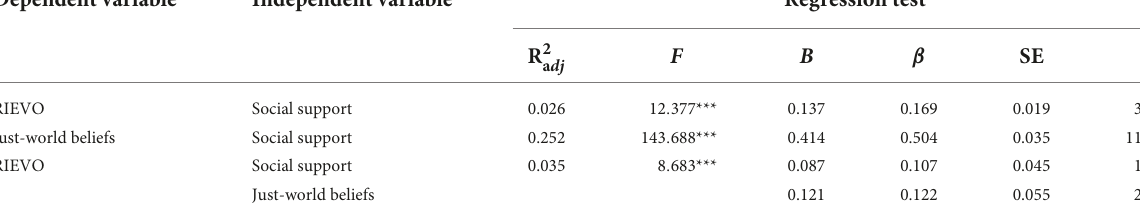
TABLE 2 Results of the regression for mediating effects of just-world